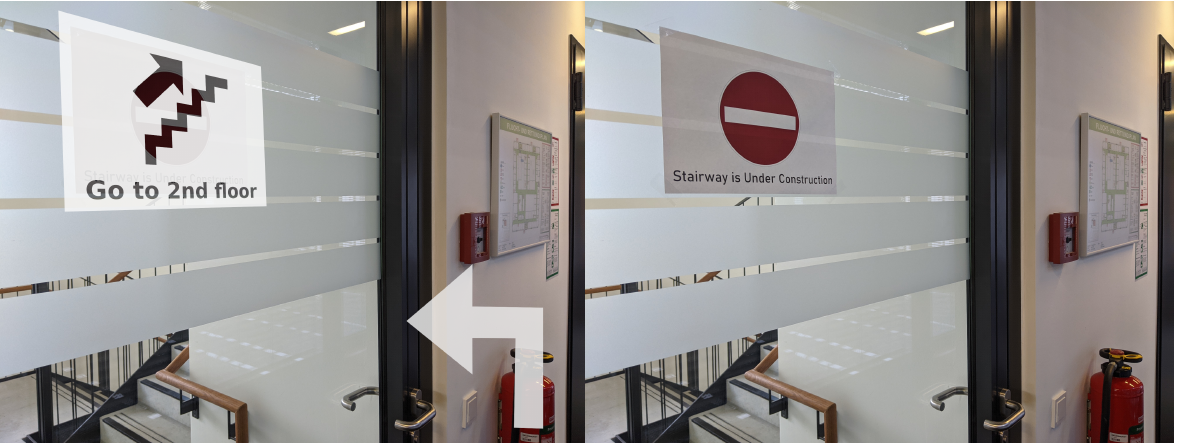
Figure 3. Instructions and overlays of an AR system may contradict or worse hide real world information. Users should be enabled to deal with such